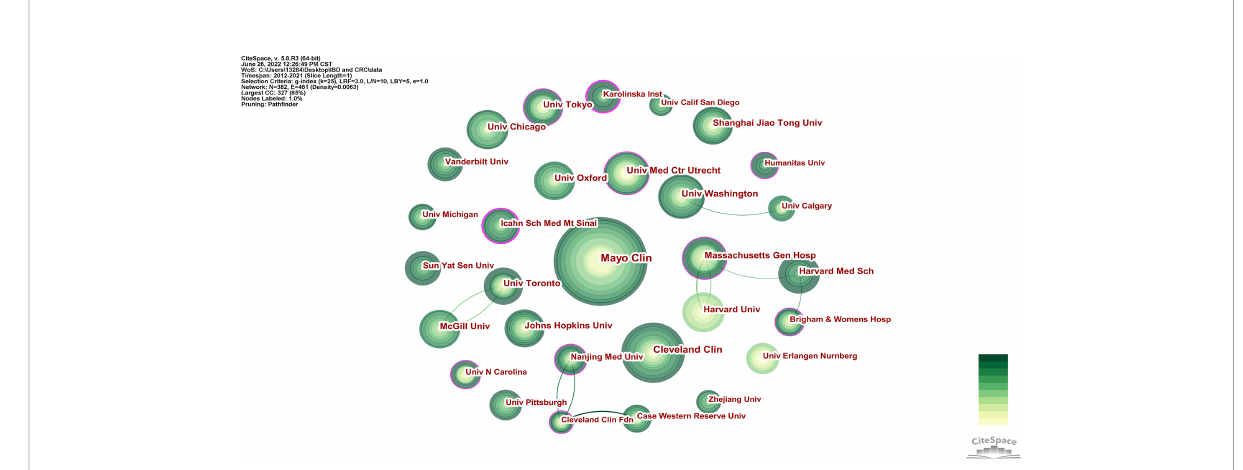
FIGURE 4 Visualization of cooperation relationship of institutions with more than 20